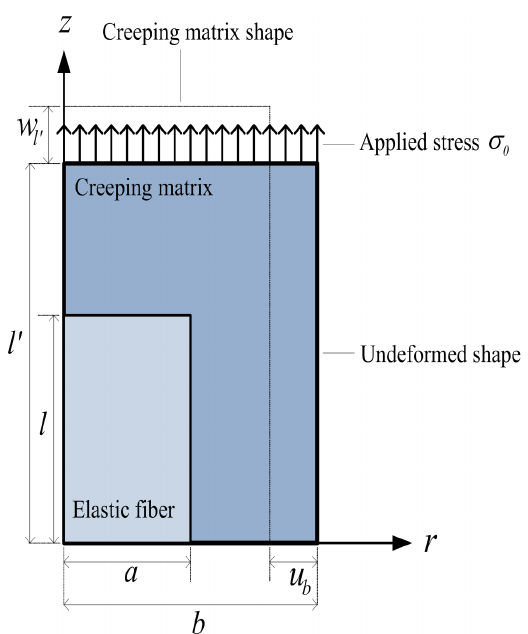
Figure 2. Creeping deformed and undeformed edges in the